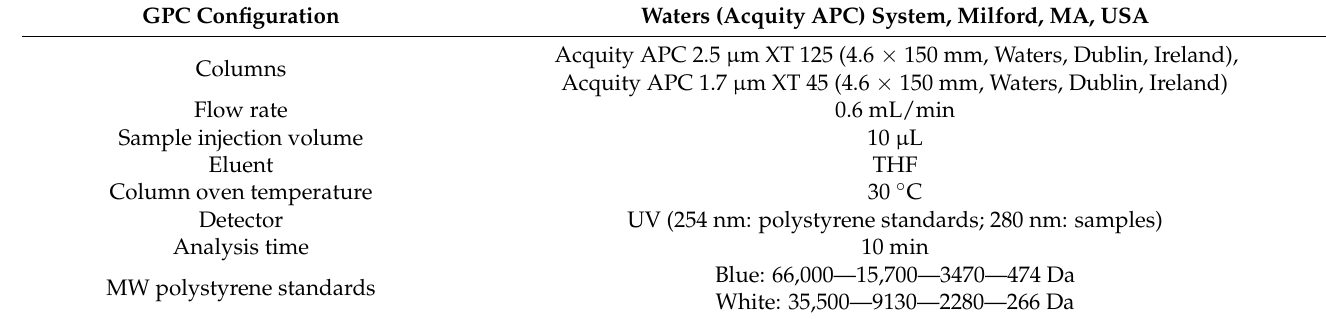
Table 9. Analysis conditions for